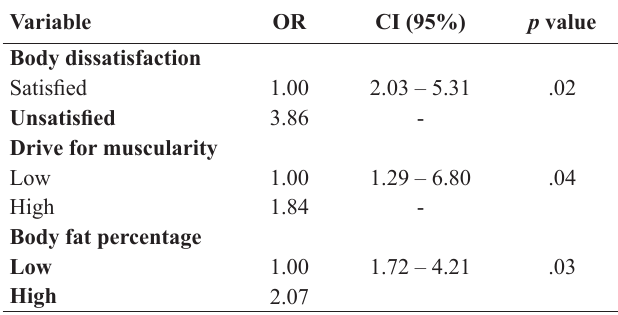
Table 4. Multinomial Regression that used the Dichotomous Clas- sification of BSQ, DMS and Body Fat Percentage for Evaluate the disordered eating Odds Ratio in Male Surf